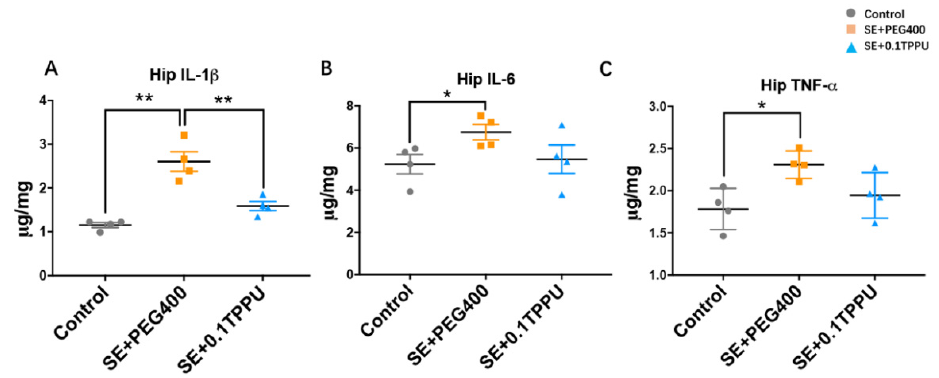
Figure 5. The levels of pro-inflammatory cytokines including IL-1 β , IL-6, and TNF- α were signifi- cantly increased in the hippocampus and prefrontal cortex of the SE+PEG400 group compared with the Control group ( A – C ). The level of IL-1 β was solely significantly attenuated in the hippocampus of SE+0.1TPPU group compared with the SE+PEG400 group ( A ). (Figure 5A–C , one-way ANOVA test, n = 4 in every group, * p < 0.05, ** p < 0.01). Hip, hippocampus. IL-1 β , interleukin-1 β ; IL-6, Interleukin-6; TNF- α , tumor necrosis factor.